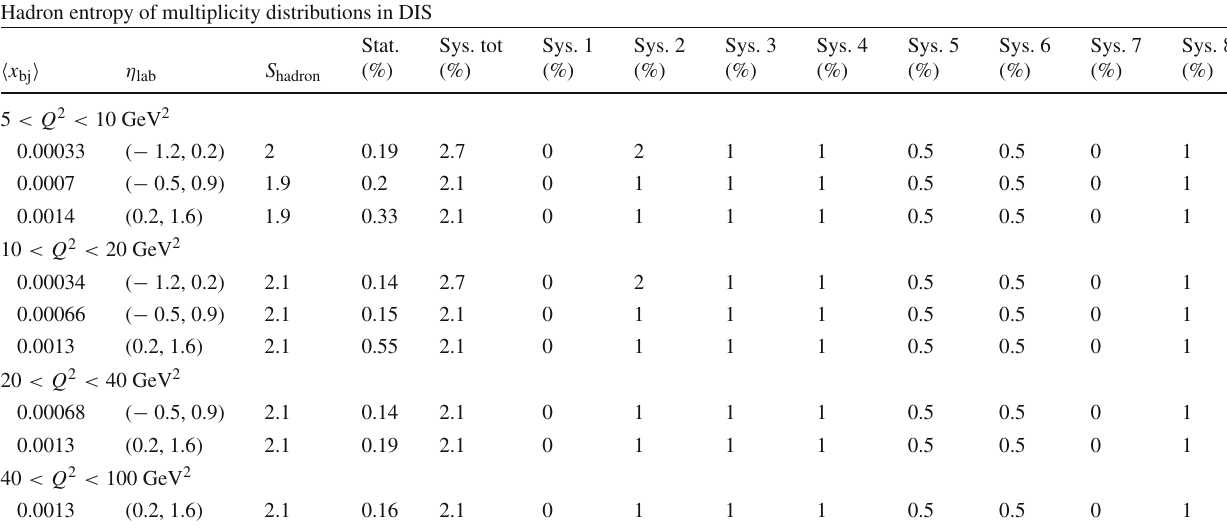
is further restricted as shown in Table 1. For this dataset, the entropy is determined in a sliding window in pseudorapidity as indicated in the table